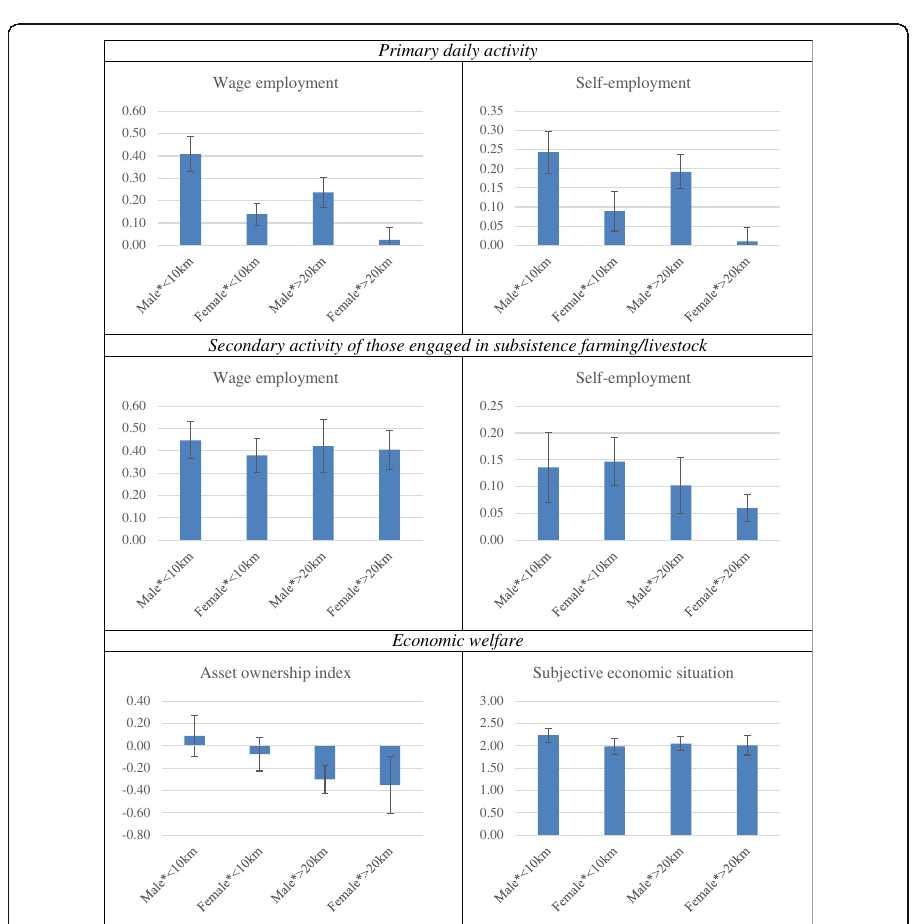
Fig. 2 Heterogeneous effects, based on